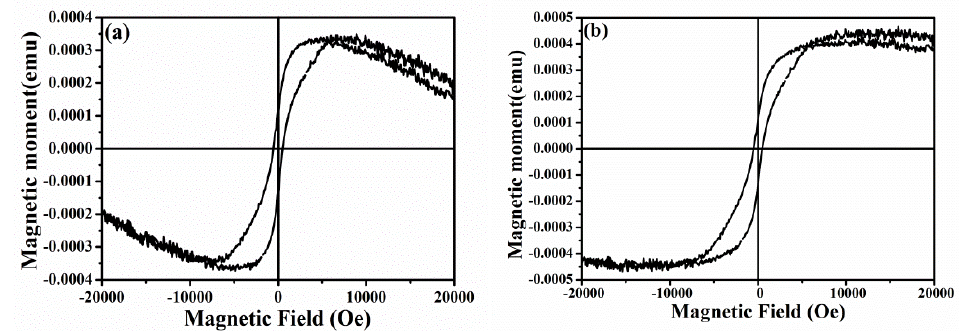
Figure 5. Room temperature M-H curve of Zn 1-x Ni x O nanorod arrays. ( a ) Without deducting the diamagnetism of silicon substrate; ( b ) room temperature M-H curve after deducting the diamagnetism of silicon substrate.